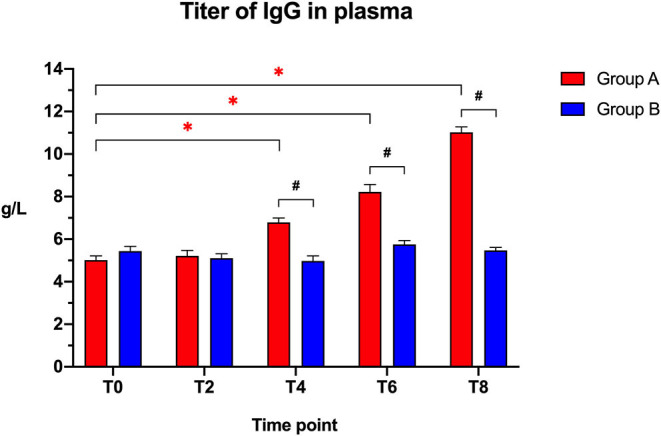
Immunoglobulin IgG titers in the plasma collected at the beginning of the study (T0), after 2 weeks (T2), 4 weeks (T4), 6 weeks (T6), and 8 weeks (T8) in dogs fed the same diet with (Group A) or without (Group B) Slab51® probiotic supplement. Black hashtags indicate statistical significance between groups. Red asterisks indicate statistical significance by study times within group A.